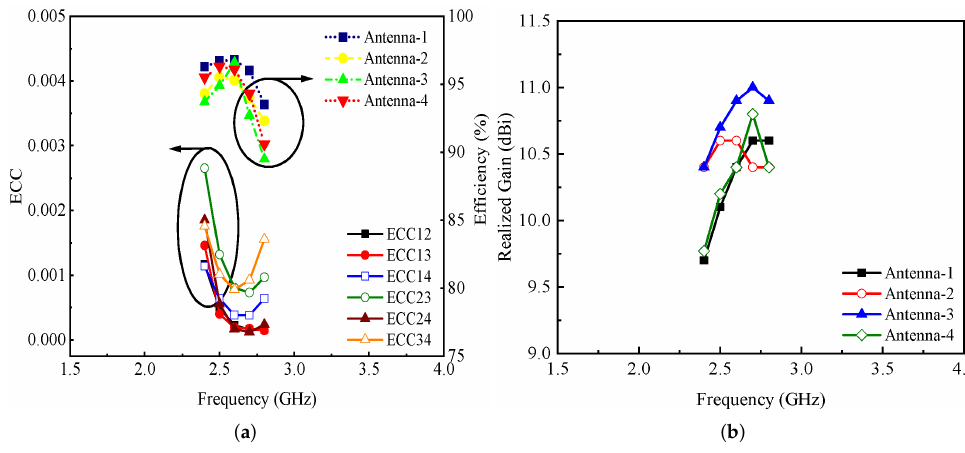
Figure 7. ( a ) ECC, efficiency, and ( b ) realized gain of the proposed Kirigami MIMO antenna. The far-field radiation characteristics of the proposed MIMO antenna are illustrated in Figure 8. For clarity, the radiation characteristics of antennas 1 and 2 are discussed in